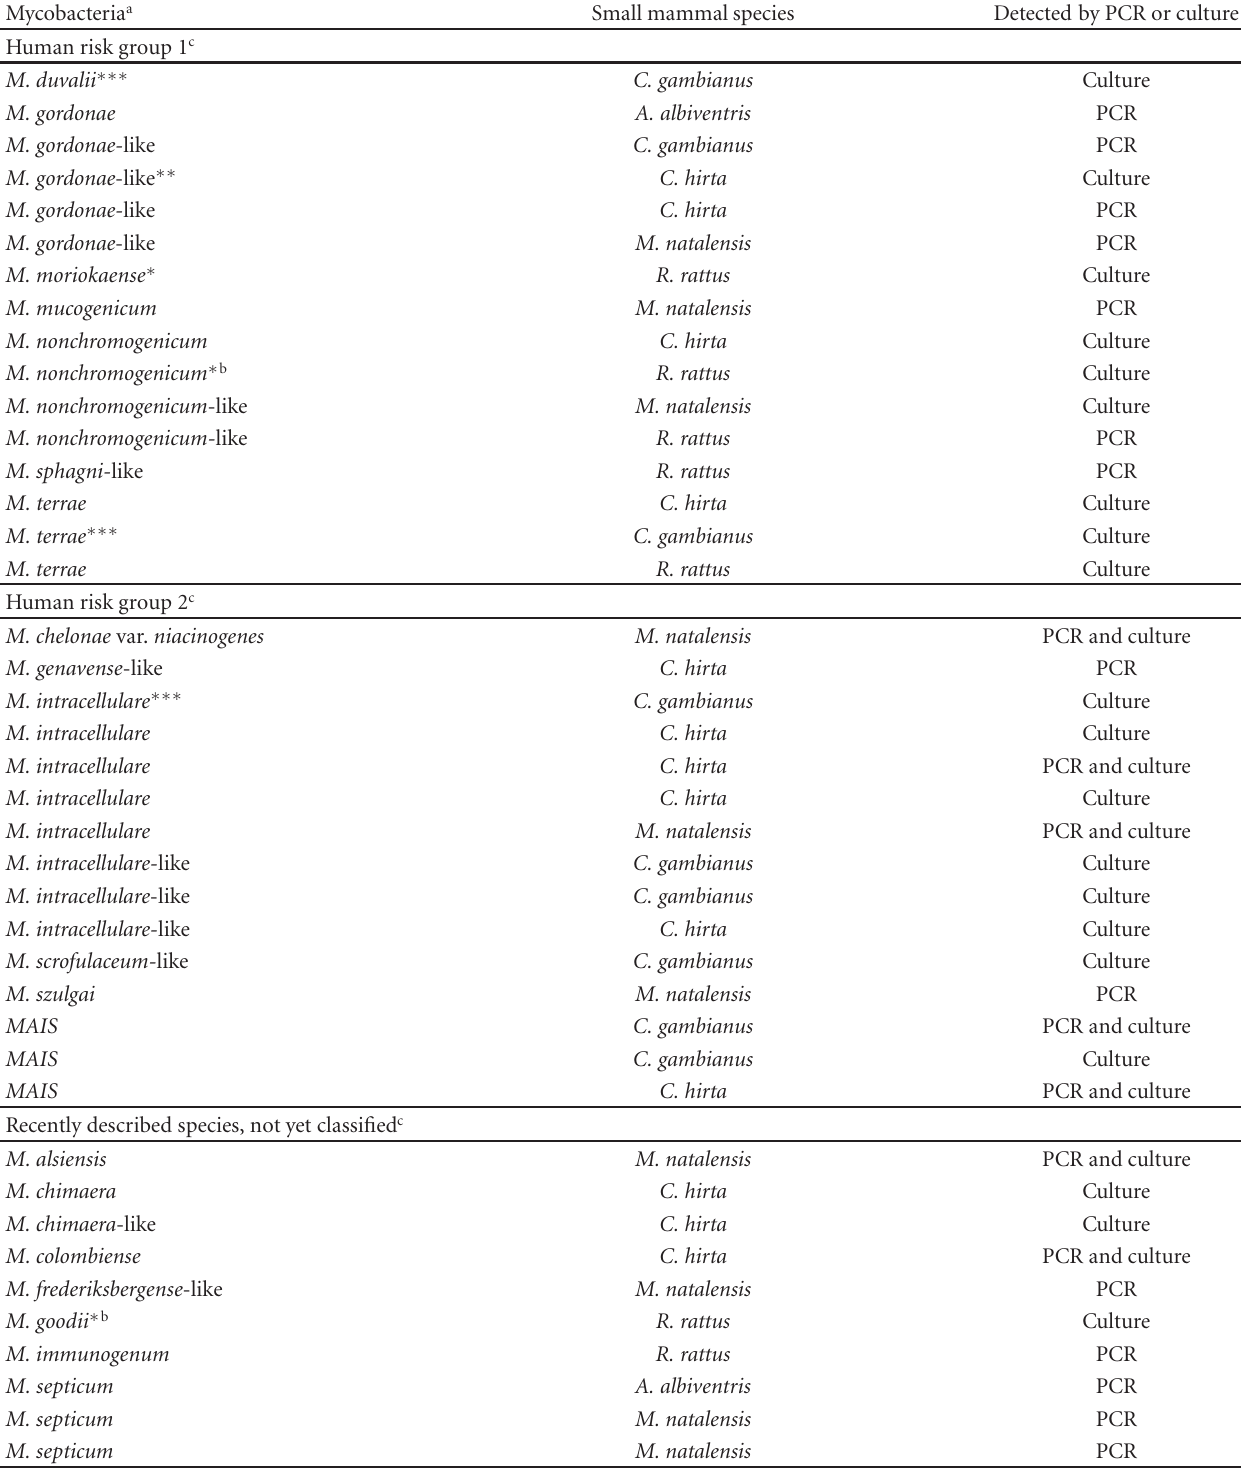
Table 3: Mycobacteria detected in rodent and insectivores in and around Morogoro,